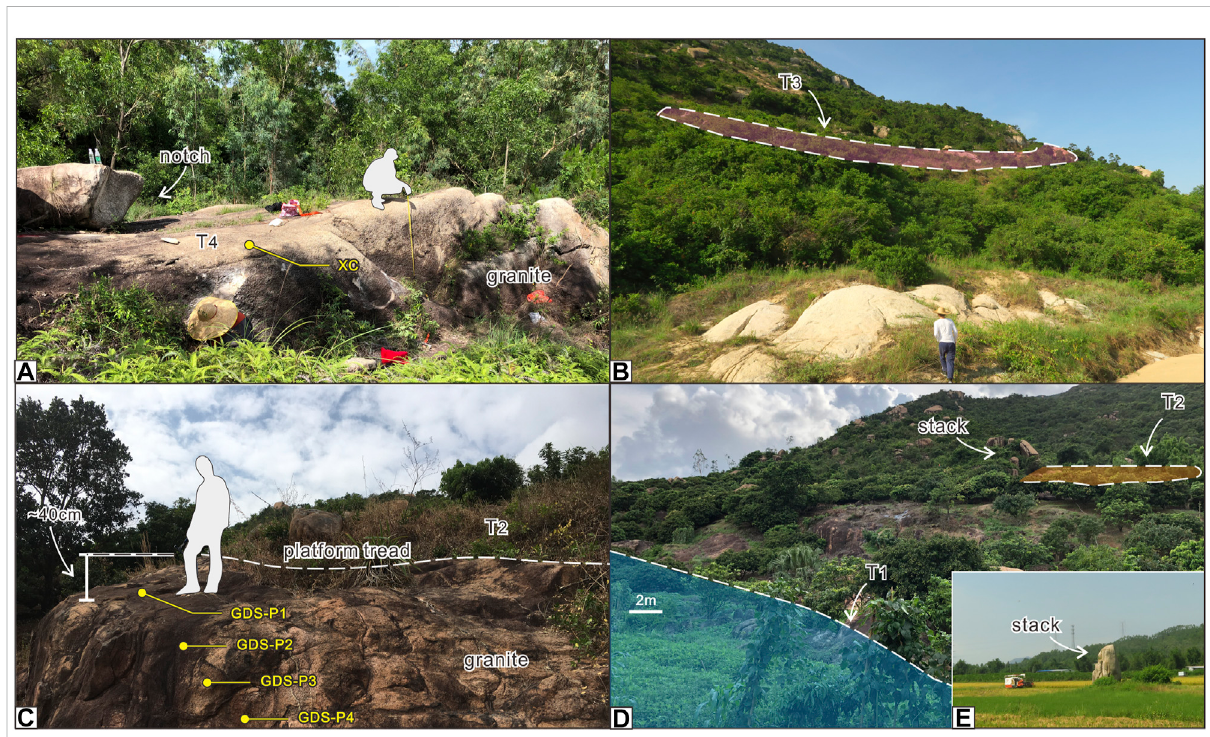
FIGURE 4 (A) ViewoftheT 4 platformwithanotchclosetotheinneredge. (B) ViewoftheT 3 (redshading)platform. (C) TheT 2 platformandthelocationsof 10 Be cosmogenic dating depth pro fi le samples; note that approximately 40 cm of bedrock was eroded. (D) View of T 2 (yellow shading), and T 1 (blue shading) platforms. (E) The sea stack is preserved on the T 1 platform close to the coastal